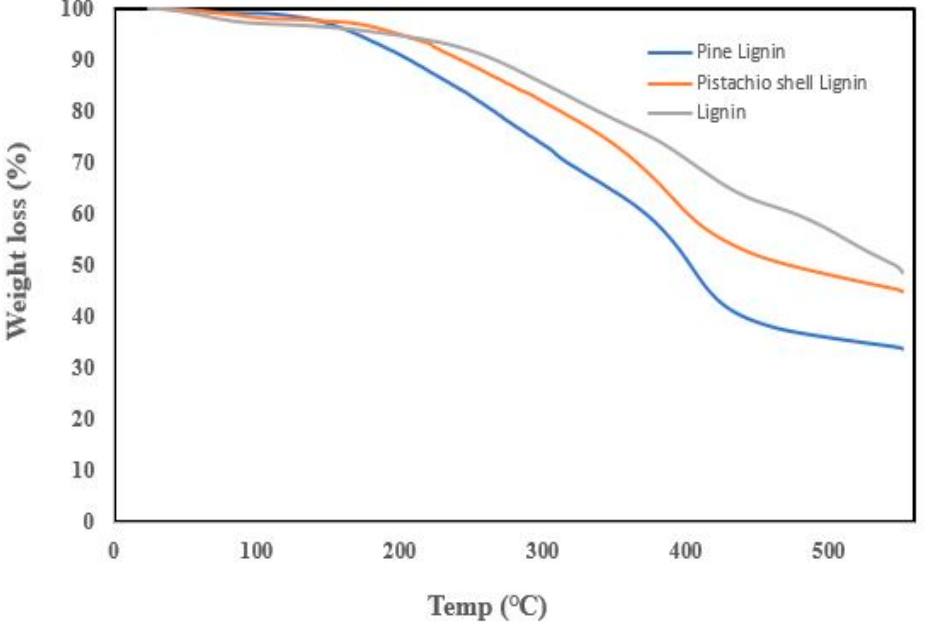
Figure 5. TGA plots of lignin from pistachio shells, pine sawdust, and commercial lignin obtained under nitrogen atmosphere at 10 °C/min.